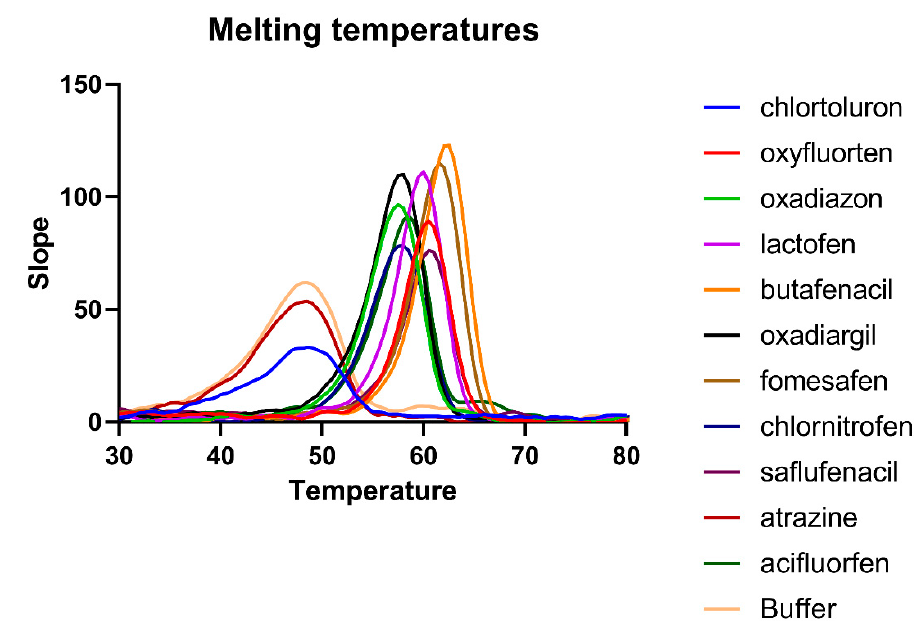
Figure 4. Thermal denaturation profiles of the hPPO complexes. The T M values of the hPPO/herbicide complexes were determined using the ThermoFAD assay, and the peak of the first derivative of the FAD fluorescence represents the T M of a given complex. Table 1. IC 50 values against hPPO for the tested inhibitors and meting temperatures for the hPPO inhibitor complexes.